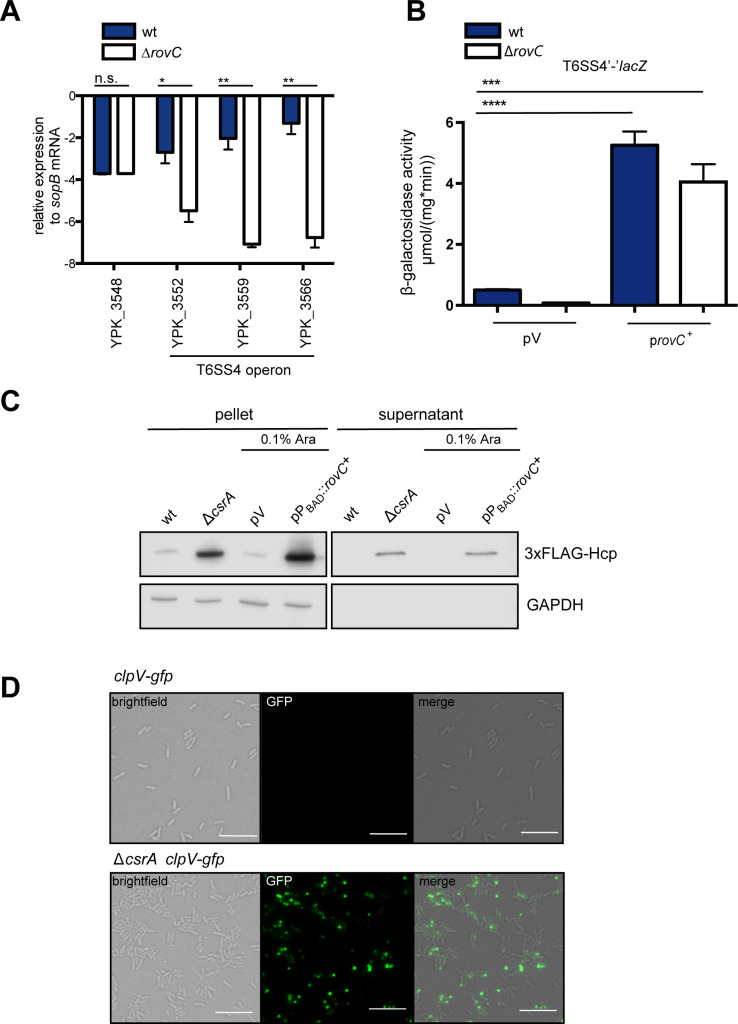
RovC activates expression of the T6SS4 operon.(A) RT-PCR analysis of selected genes of the T6SS4 cluster region was performed with total RNA isolated from at least three independent cultures of Y. pseudotuberculosis wildtype (YPIII) and the ΔrovC mutant strain (YP148). Expression levels were normalized to the sopB reference transcript according to Pfaffl 2001 [70] and are given as relative expression of the respective gene in relation to sopB. Data are given as means ± standard deviation and were analyzed by Student's t test. Asterisks indicate the results that differed significantly with ** P < 0.01, * P < 0.05, n.s. = not significant. (B) β-galactosidase activity (μmol/mg.min) of a translational T6SS4’-‘lacZ reporter fusion (pSSE64) was monitored in Y. pseudotuberculosis wildtype (YPIII) and the ΔrovC mutant (YP148) harboring the empty vector pACYC184 (pV) or the rovC+ plasmid pSSE11 (provC+) grown over night at 25°C. The data represent the mean ± standard deviation of three independent experiments, carried out in triplicates. Data were analyzed by Student’s t-test; ****P < 0.0001; ***P < 0.001. (C) Expression and secretion of the T6SS4 tube protein Hcp was analyzed with Y. pseudotuberculosis YPIII (wt), YP53 (ΔcsrA), YPIII pBAD30 (pV) and YPIII pVK25 (pPBAD::rovC+) harboring a chromosomally-encoded gene for the N-terminal 3x FLAG-tagged Hcp protein. Strains were grown in LB at 25°C +/- 0.1% arabinose and whole cell extracts and supernatant samples were prepared, separated on 15% polyacrylamide gels and 3x-FLAG-Hcp and GAPDH were detected by western blotting using a monoclonal α FLAG and polyclonal GAPDH antibody. A representative image of three independent experiments is shown. (D) T6SS4-activity in Y. pseudotuberculosis strains YP412 (clpV-gfp) or YP417 (clpV-gfp, ΔcsrA) grown in LB at 25°C was monitored by the identification and location of the T6SS4-associated ClpV-GFP protein using fluorescence microscopy. Cultures were grown in LB to reach an OD600 of 2.5 in LB. A representative image of three independent experiments is shown. The scale bar represents 10 μm.